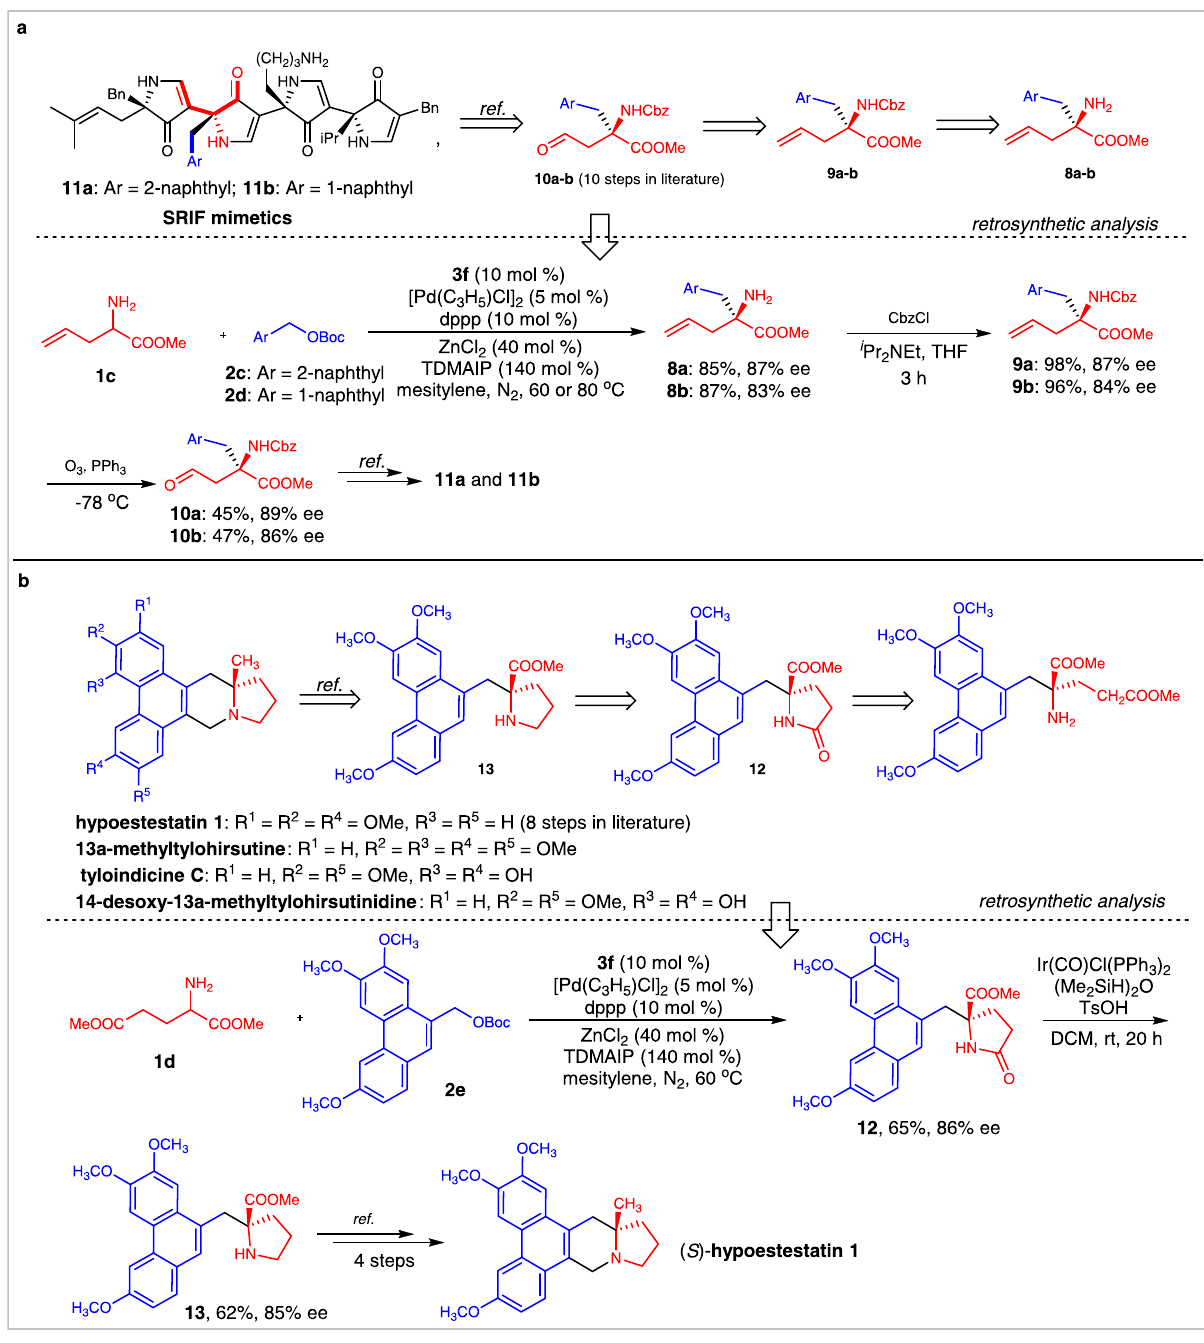
Fig. 5 Synthetic applications. a The retrosynthetic analysis and formal synthesis of somatotropin release inhibiting factor (SRIF) mimetics. b The retrosynthetic analysis and formal synthesis of ( S )-hypoestestatin 1 . TDMAIP